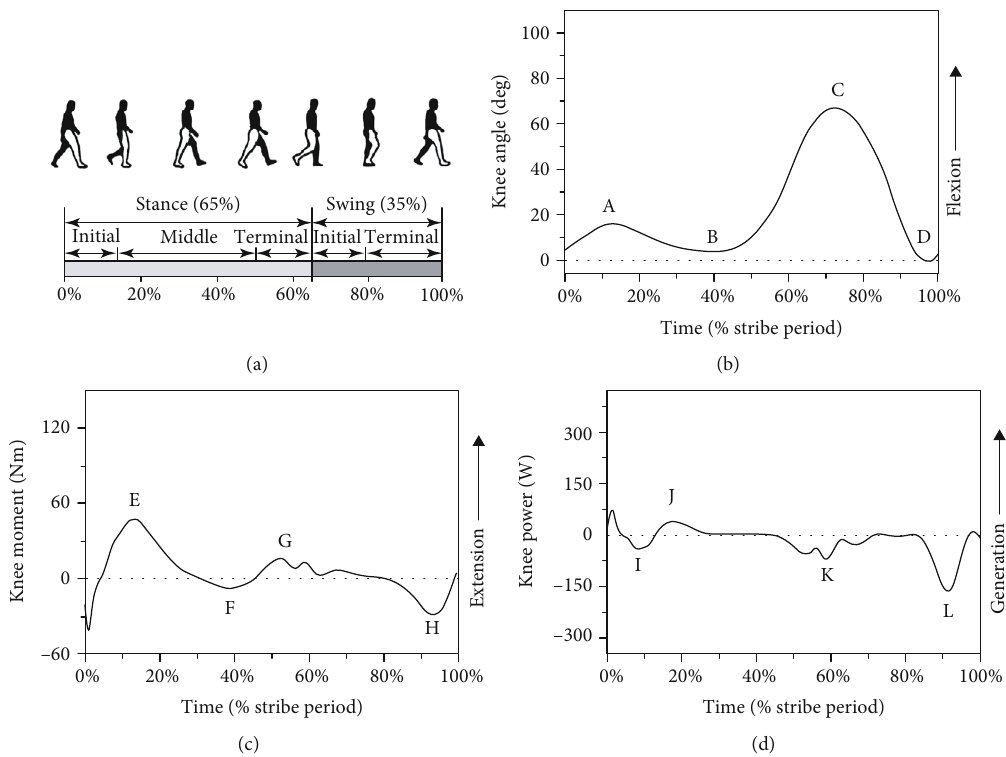
Figure 2: A sketch map of motion and the typical curves of knee angle, moment, and power in the sagittal plane for a walking gait cycle. (a) Sketch map of walking motion [14]. (b) Knee angle-time curve ((A) fi rst peak knee fl exion angle, (B) fi rst peak knee extension angle, (C) second peak knee fl exion angle, and (D) second peak knee extension angle). (c) Knee moment-time curve ((E) fi rst peak knee extension moment, (F) fi rst peak knee fl exion moment, (G) second peak knee extension moment, and (H) second peak knee fl exion moment). (d) Knee power-time curve ((I) fi rst peak knee absorption power, (J) fi rst peak knee generation power, (K) second peak knee absorption power, and (L) third peak knee absorption power) [16, 17]. Table 1: Overview over the experimental results of knee angle for normal